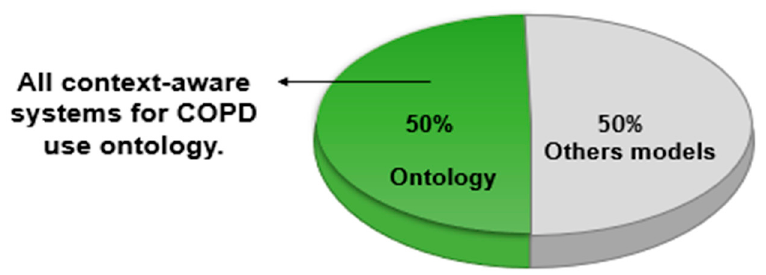
Figure 6. Percentage use of Ontology as compared with other models